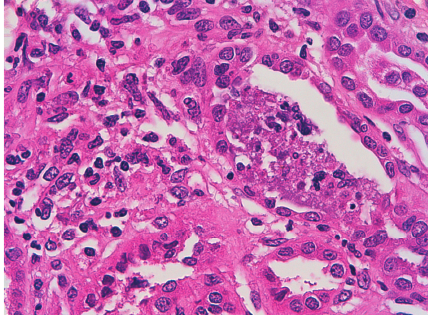
Figure 1: Renal cortex with a complete glomerulus. Mixed inflam- matoryinfiltratebetweenthecorticaltubules(lymphocytes,plasma- cells, histiocytes, and polymorphs). Hematoxylin eosin 400x.